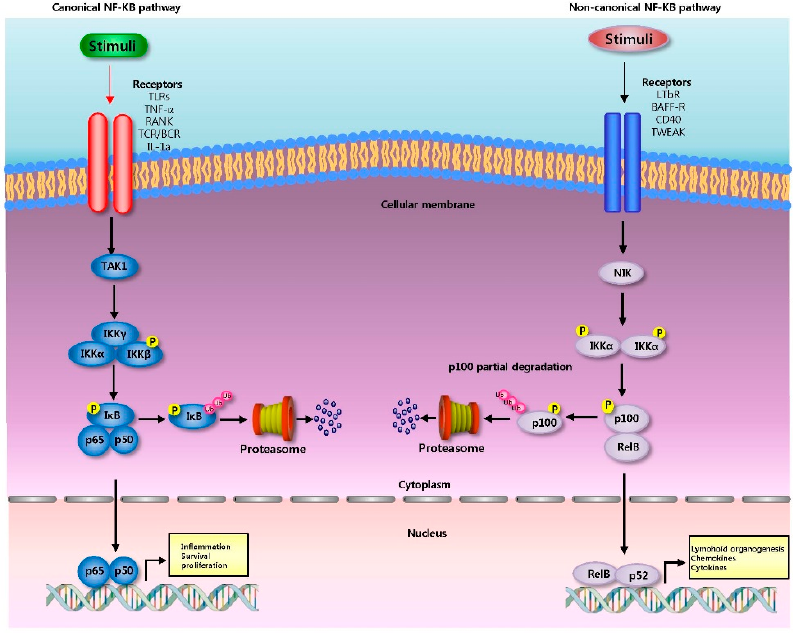
Figure 1. The canonical NF- κ B pathway ( left ) induced by signals including antigens, TLR ligands and cytokines such as TNF uses a wide variety of signaling adaptors to engage and activate the IKK β subunit of the IKK complex. IKK β phosphorylation of I κ B proteins bound to NF- κ B dimers results in ubiquitination (Ub) of I κ B and proteasome-induced degradation. This allows NF- κ B to enter the nucleus and be involved in controlling the transcription of gene encoding functions as diverse as inflammation, cell survival and cell division. The noncanonical pathway ( right ) engaged in by members of the TNF-like family of cytokines requires NIK to activate IKK α , which then phosphorylates p100 (NF- κ B2), triggering its proteosomal processing needed for the activation of p52-RelB dimers. Among its functions, this specific NF- κ B heterodimer controls gene expression crucial for lymphoid organogenesis.